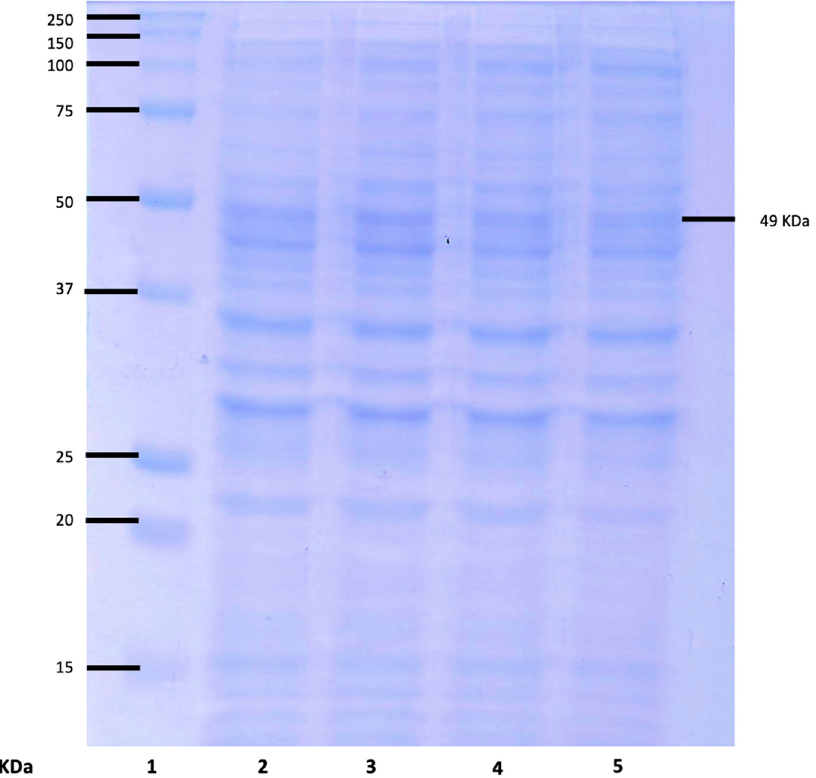
Figure 5. SDS-PAGE of crude Wt and crude Mut2 8S α globulin. Lanes: 1, protein marker; 2 and 3,